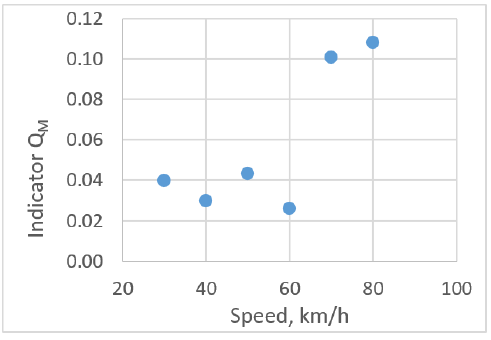
Figure 16. Values of the indicator Q M , according to the mean vertical forces of loaded wagon.